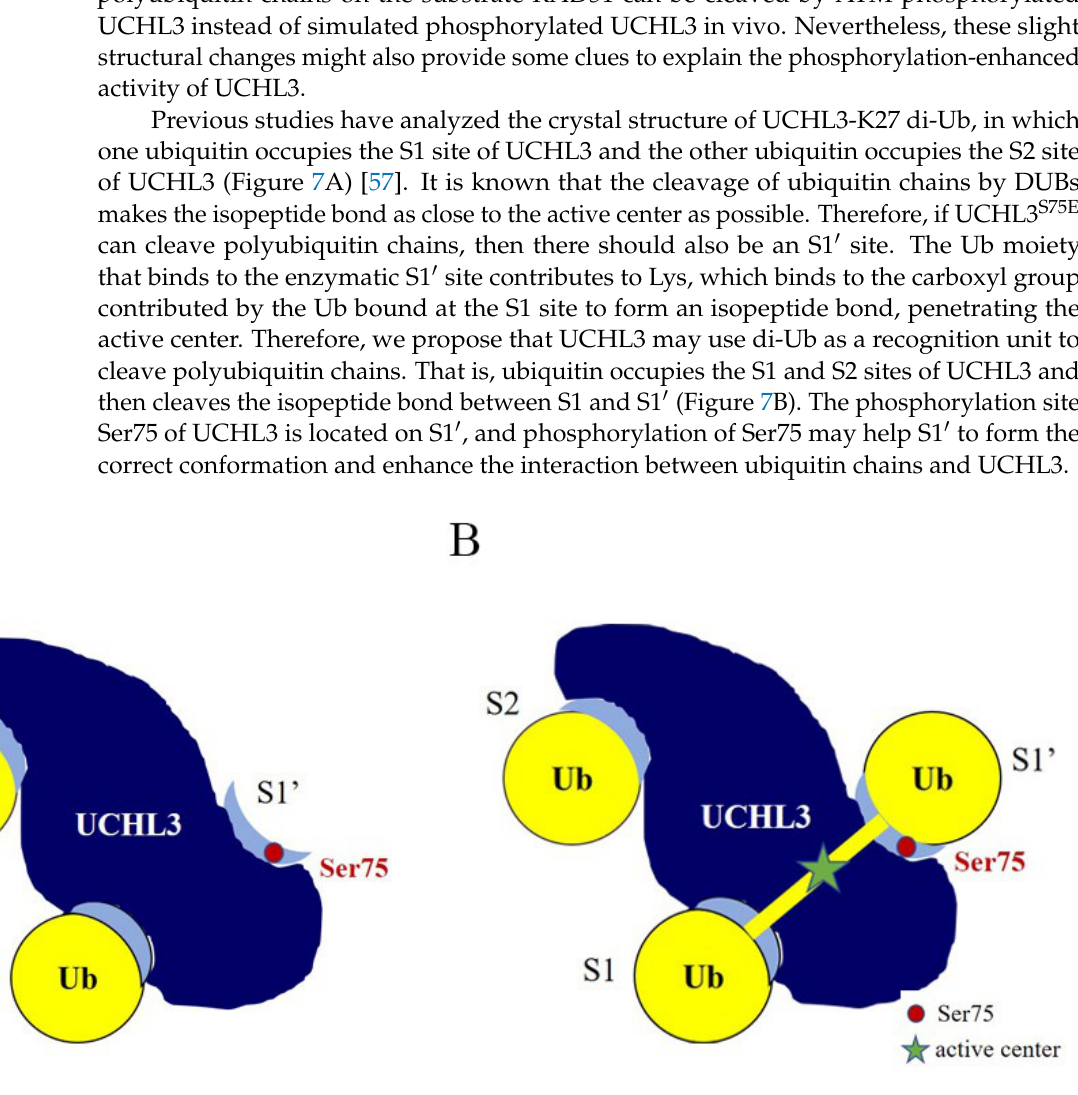
Figure 7. ( A ) Model of the complex of UCHL3 bound to K27 di-Ub. ( B ) Model of phosphorylation- modified UCHL3 hydrolyzing ubiquitin chains.